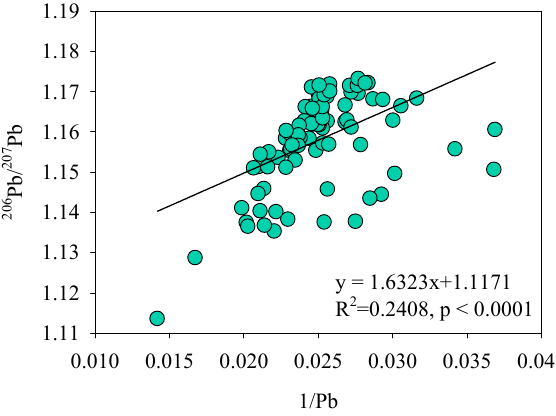
Figure 1. Relationships between Pb contents and 206 Pb / 207 Pb ratios before screening by regional geochemical baseline (RGB).